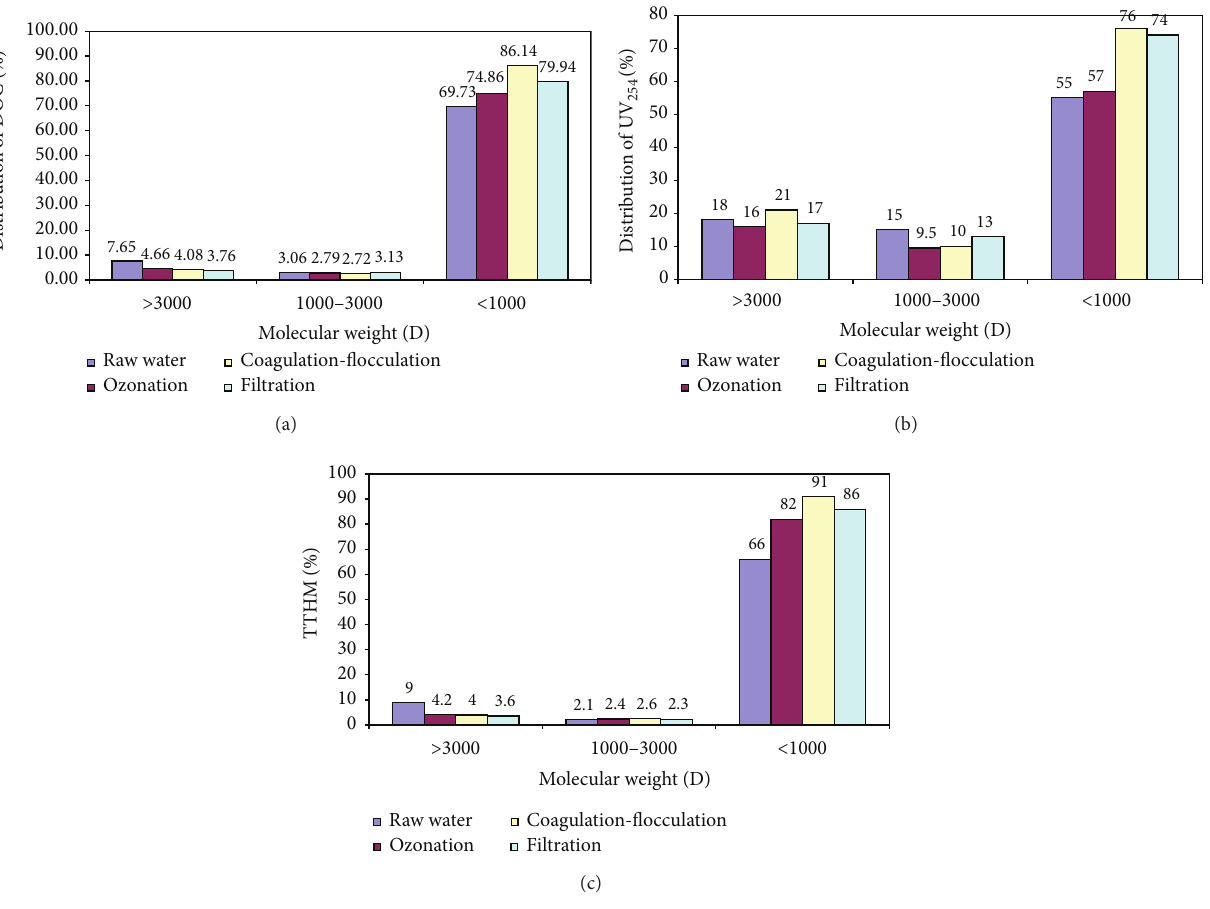
Figure 3: Percentages of distributions for (a) DOC and NOM fractions, (b) UV 254 and NOM fractions, and (c) TTHM and NOM fractions.